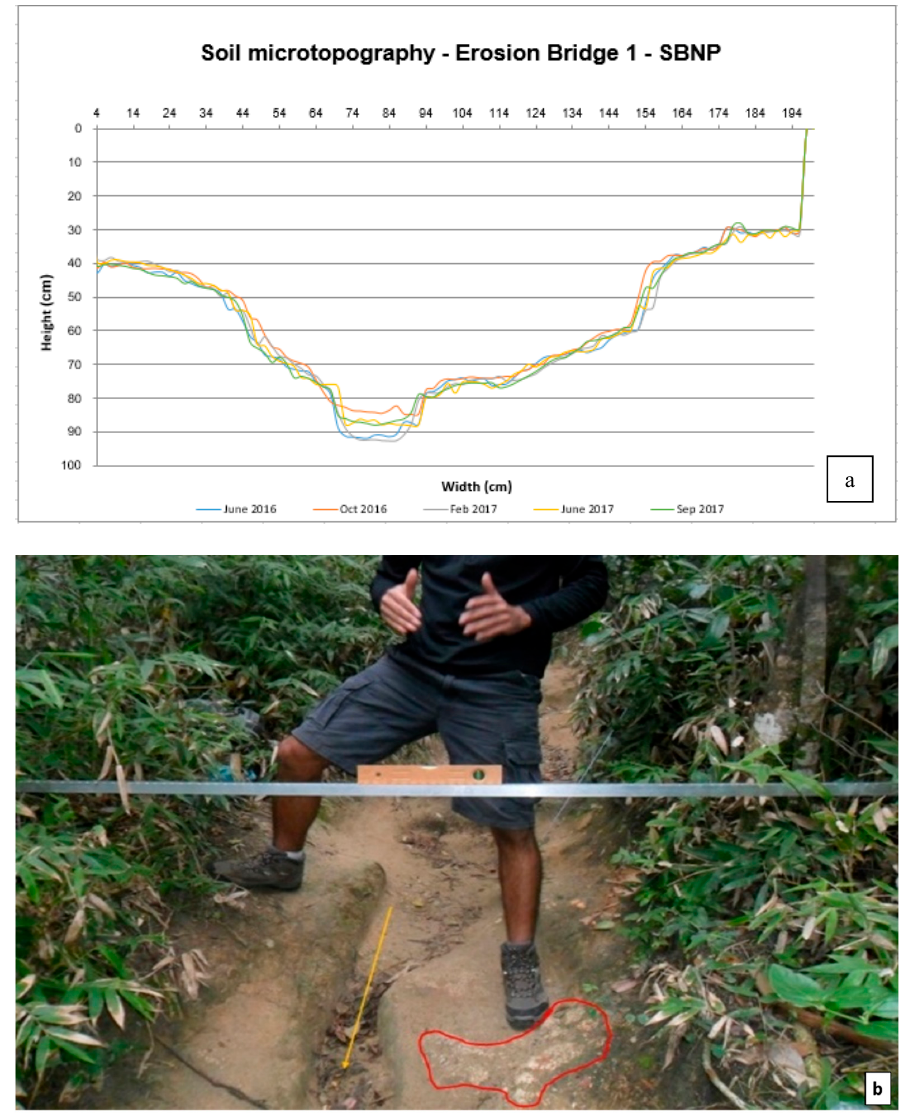
Figure 5. ( a ) Soil microtopographic analysis between June 2016 and September 2017 on EB1. ( b ) The yellow arrow indicates a rill containing accumulated litter. The red highlight indicates the onset of the exposure of the C horizon. Photo: L. Rangel (2017).